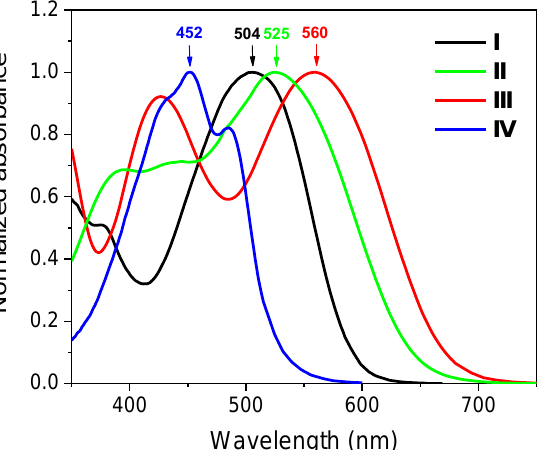
Figure 3. UV-vis normalized absorption spectra of materials I – IV studied in thin films cast from THF solution.